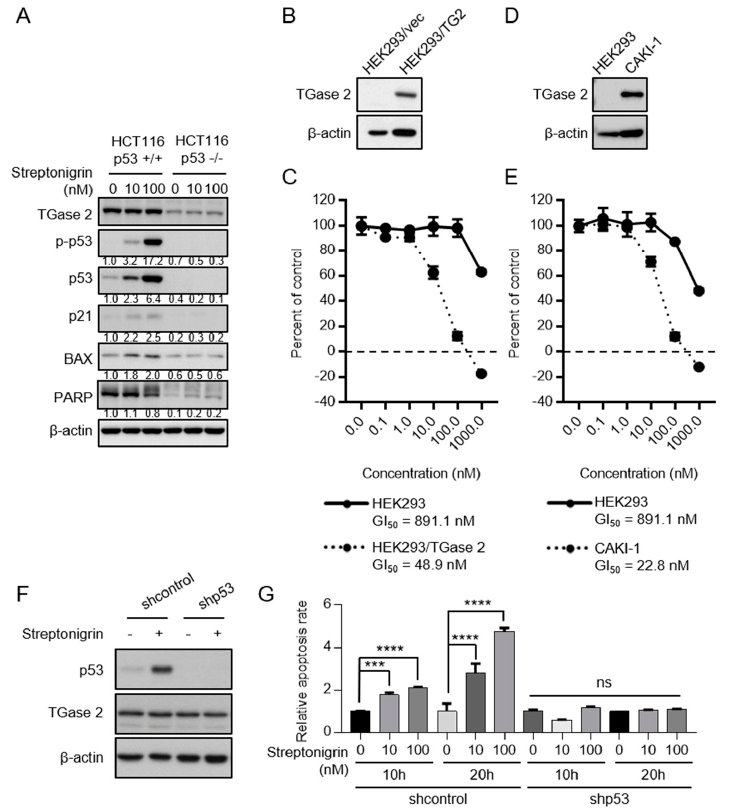
Figure 4. Streptonigrin acts as a specific TGase 2 inhibitor and induces p53-dependent cell death in HCT116 and HEK293 cells. ( A ) HCT116(p53 +/+) and HCT116(p53 − / − ) cells were treated for 12 h with different doses of streptonigrin and subjected to immunoblotting with the indicated antibodies. ( B ) Western blot showing TGase 2 expression in HEK293 and HEK293/TGase 2 cells (transiently transfected with TGase harboring a 2-HA tag). ( C ) Sulforhodamine B (SRB) assay to examine streptonigrin-induced cytotoxicity in HEK293 and HEK293/TGase 2 cells exposed to the indicated concentrations of the compound. ( D ) Western blot showing TGase 2 expression in HEK293 and CAKI-1 cells. ( E ) SRB assay of streptonigrin cytotoxicity in HEK293 and CAKI-1 cells exposed to the indicated concentrations of the compound. ( F ) CAKI-1 shcontrol and shp53 cells were treated with streptonigrin (100 nM) for 10 h and analyzed by immunoblotting with the indicated antibodies. ( G ) Cells were treated for 10 h or 20 h with streptonigrin (0, 10, or 100 nM) and stained with propidium iodide and annexin V and analyzed by FACS flow cytometry. ns > 0.05; *** p < 0.001 and **** p <